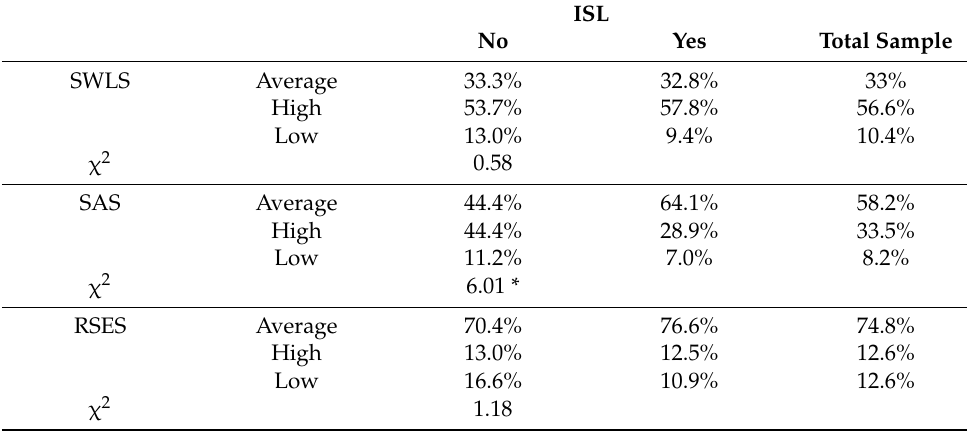
Table 4. The differences in the SSWLS, SAS, and RSES levels between those who learned ISL and who did